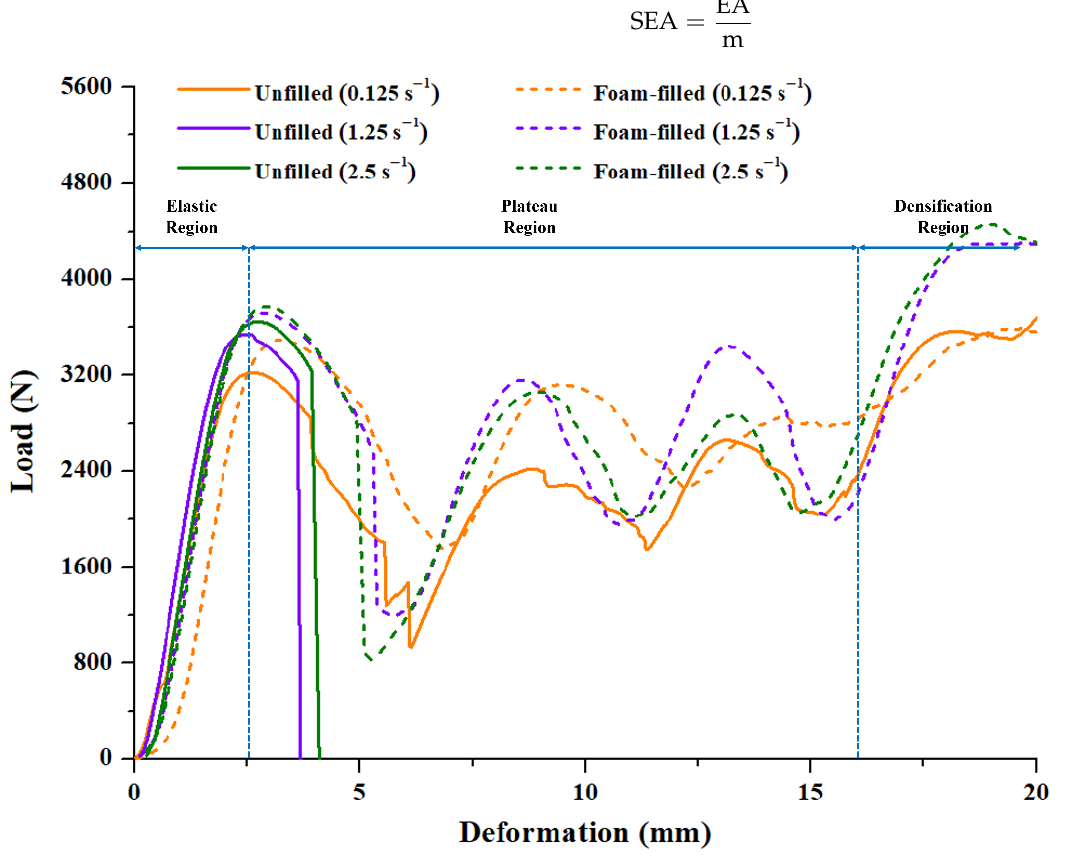
Figure 6. Load vs. deformation response unfilled and foam-filled lattice structures and 0.125 s −1 , 1.25 s −1 and 2.5 s −1 .